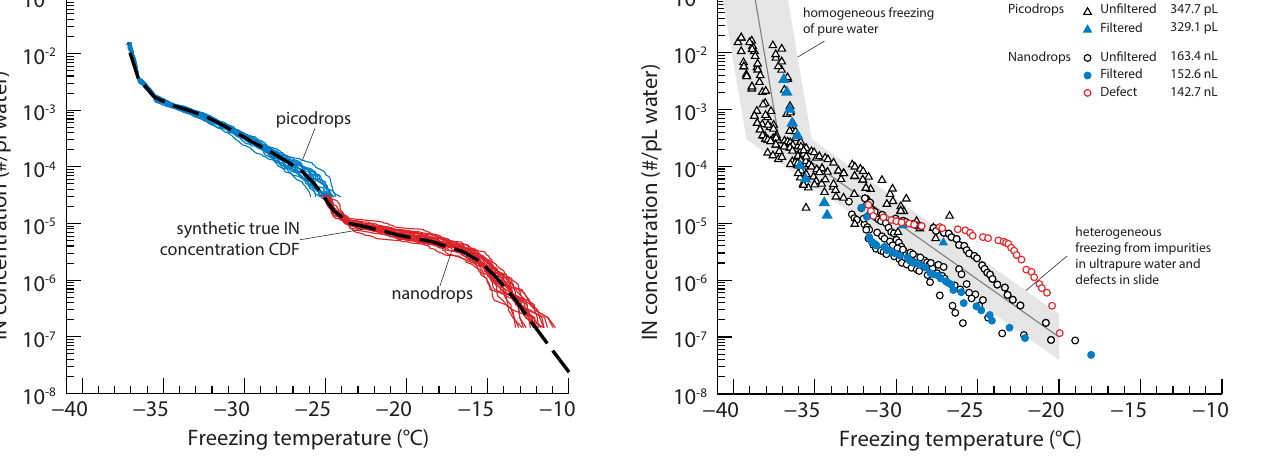
Figure 3. Summary of ice nucleation experiments with ultrapure water. Ice nuclei are expressed as the number of apparent ice nuclei per picolitre of water. Triangles represent picodrop experiments and circles represent nanodrop experiments. Filled symbols indicate fil- tered/resuspended data. Red circles demonstrate transient noise in the nanodrop experiments in the − 20 to − 30 ◦ C range. Indicated in the top right corner is the average median drop volume for each class of droplets. The grey shaded area indicates an estimate of the experiment-to-experiment variability. The dark grey line cor- responds to the average concentration of impurities present in the